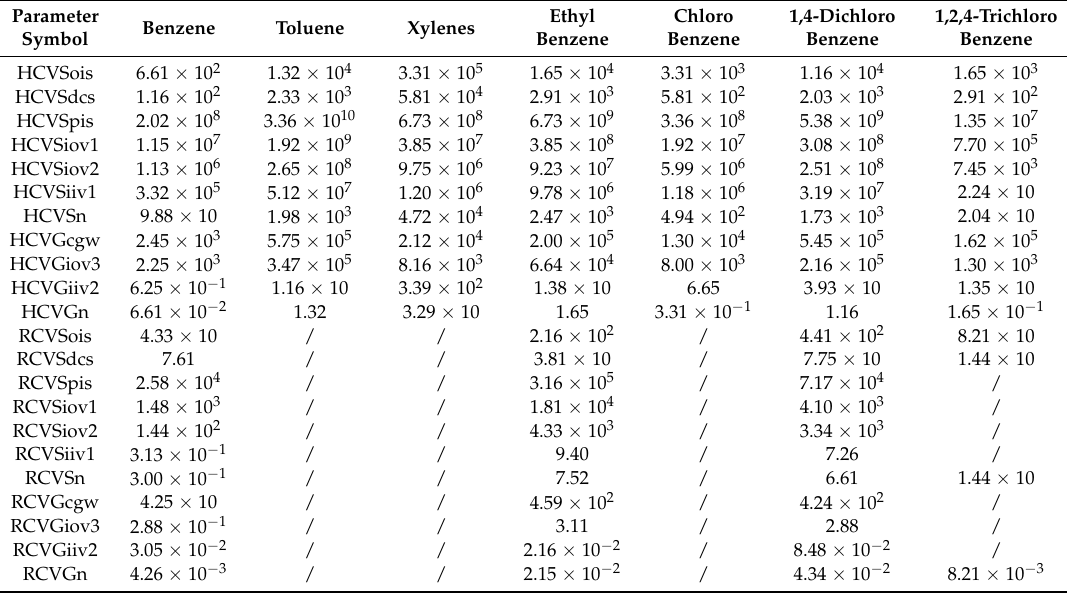
Table 6. Risk control values of soil and groundwater based on non-carcinogenic effects and carcinogenic effects at the LuHe